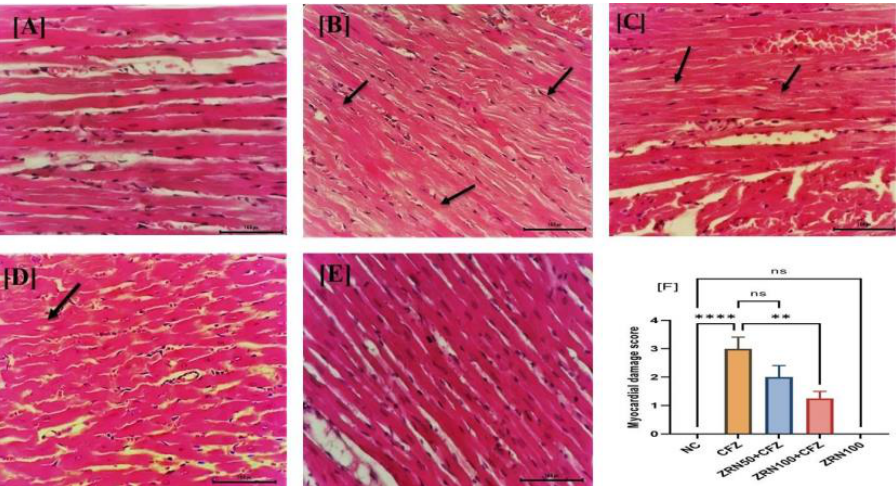
Figure 4. ( A – F ) Effects of zingerone on carfilzomib-induced myocardial histopathology of different experimental groups represented in hematoxylin and eosin (HE) staining. ( A ) NC with normal myocardium morphology, score—0; ( B ) CFZ changes heart histology with loss of myofibrils and cytoplasmic vacuolization score—3; ( C , D ) heart myocardial lesion was improved with zingerone treatment (50 and 100 mg/kg) score—2 and score—1; and ( E ) zingerone did not alter the morphology of myocardium score—0. ( F ) The myocardial injury score in all groups with significant injury ** p < 0.0021 vs. CFZ, **** p < 0.0001 vs. NC, ns p > 0.0921. Abbreviations: NC: Normal control, CFZ: Carfilzomib, ZRN: